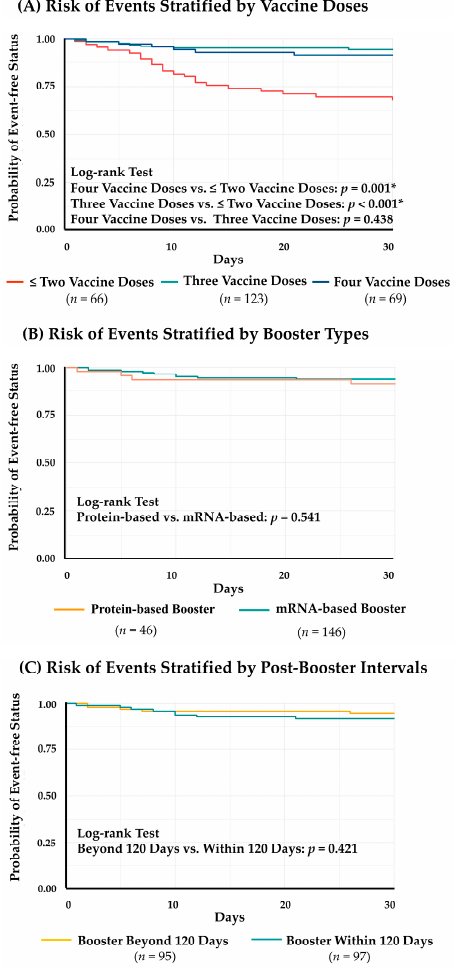
Figure 3. Risk of Composite Events Stratified by Vaccine Doses, Booster Types, and Post-Booster Intervals in the Enrolled HD Patients. ( A ). Risk of events stratified by vaccine doses ( n = 258); ( B ). Risk of events stratified by booster types ( n = 192); ( C ). Risk of events stratified by post-booster intervals ( n = 192). *: p <